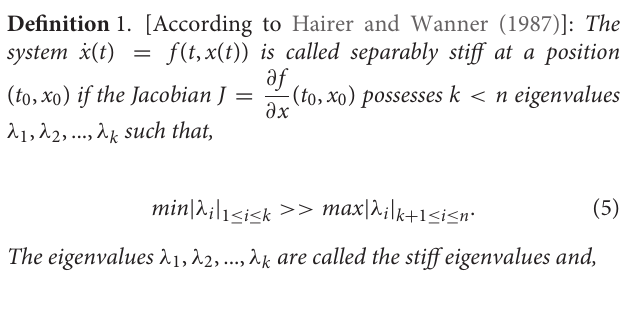
TABLE 1 | Comparison of KF, EKF, and UKF considering the main principles of filtering. Method